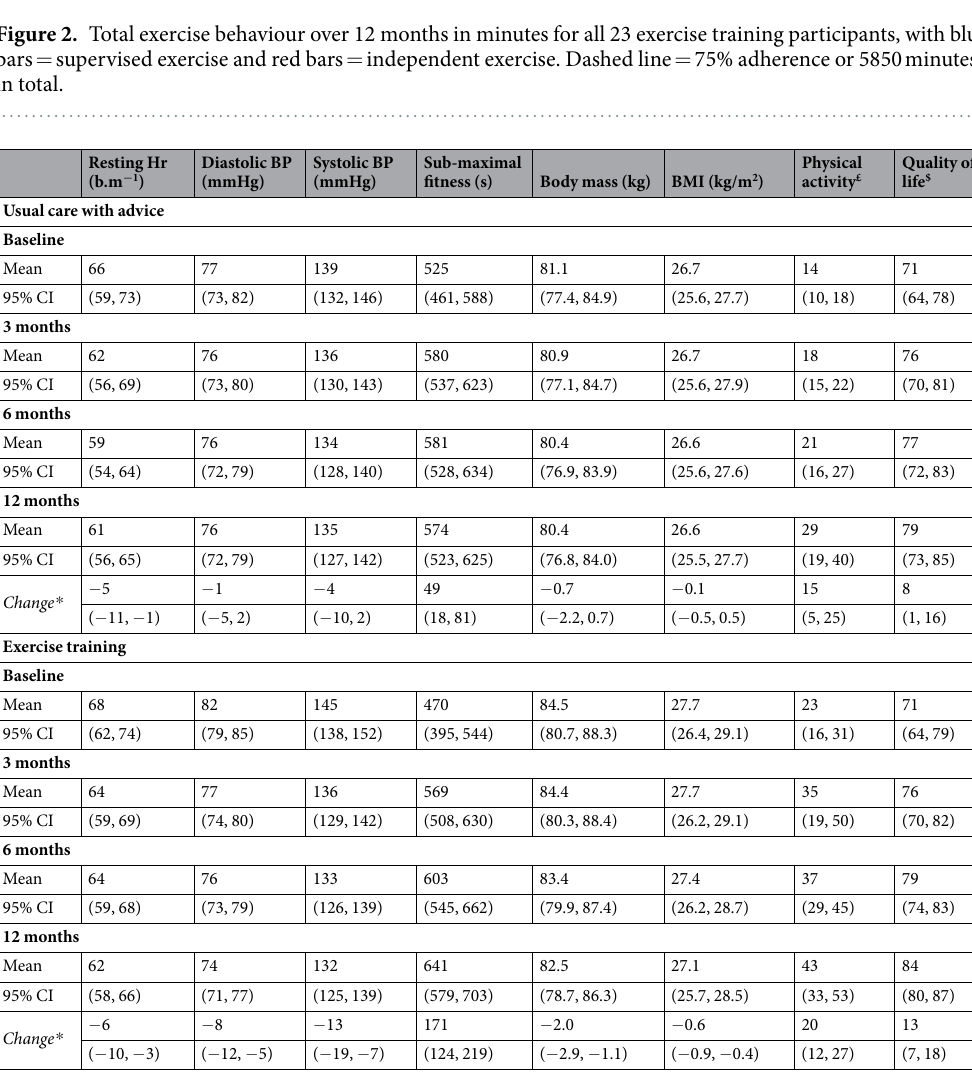
Table 2. Secondary outcomes from the trial. Data is from 46 men completing 12 months follow-up. * Mean difference between baseline and 12 months with 95% confidence intervals. £ Exercise behaviour measured by